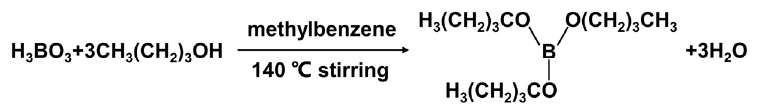
Figure 1. Esterification reaction for boron-containing amphipathic molecule.